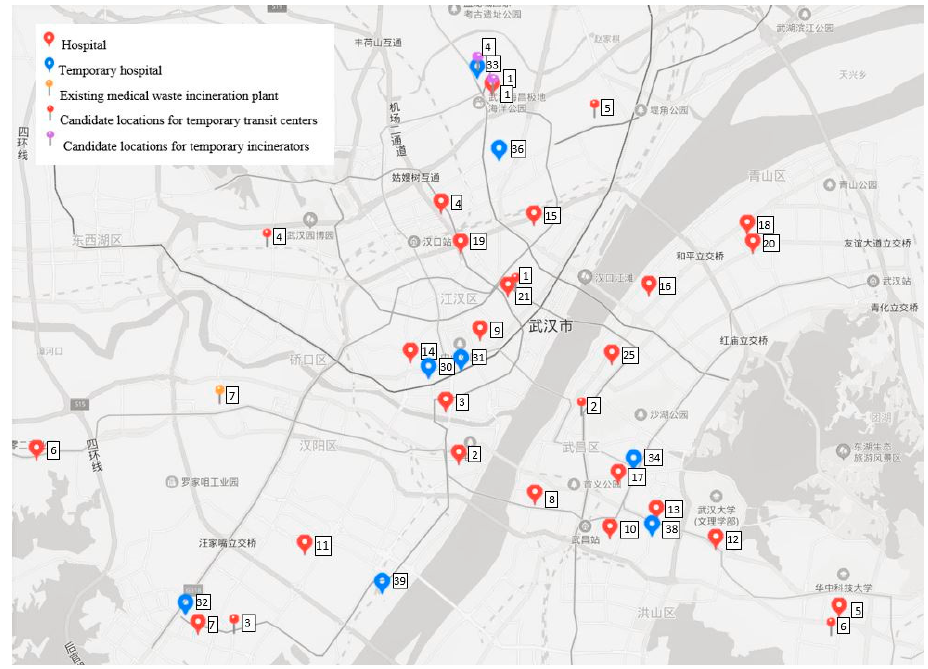
Figure 3. Locations of hospitals, existing facilities, and candidates for temporary facilities in central Wuhan.